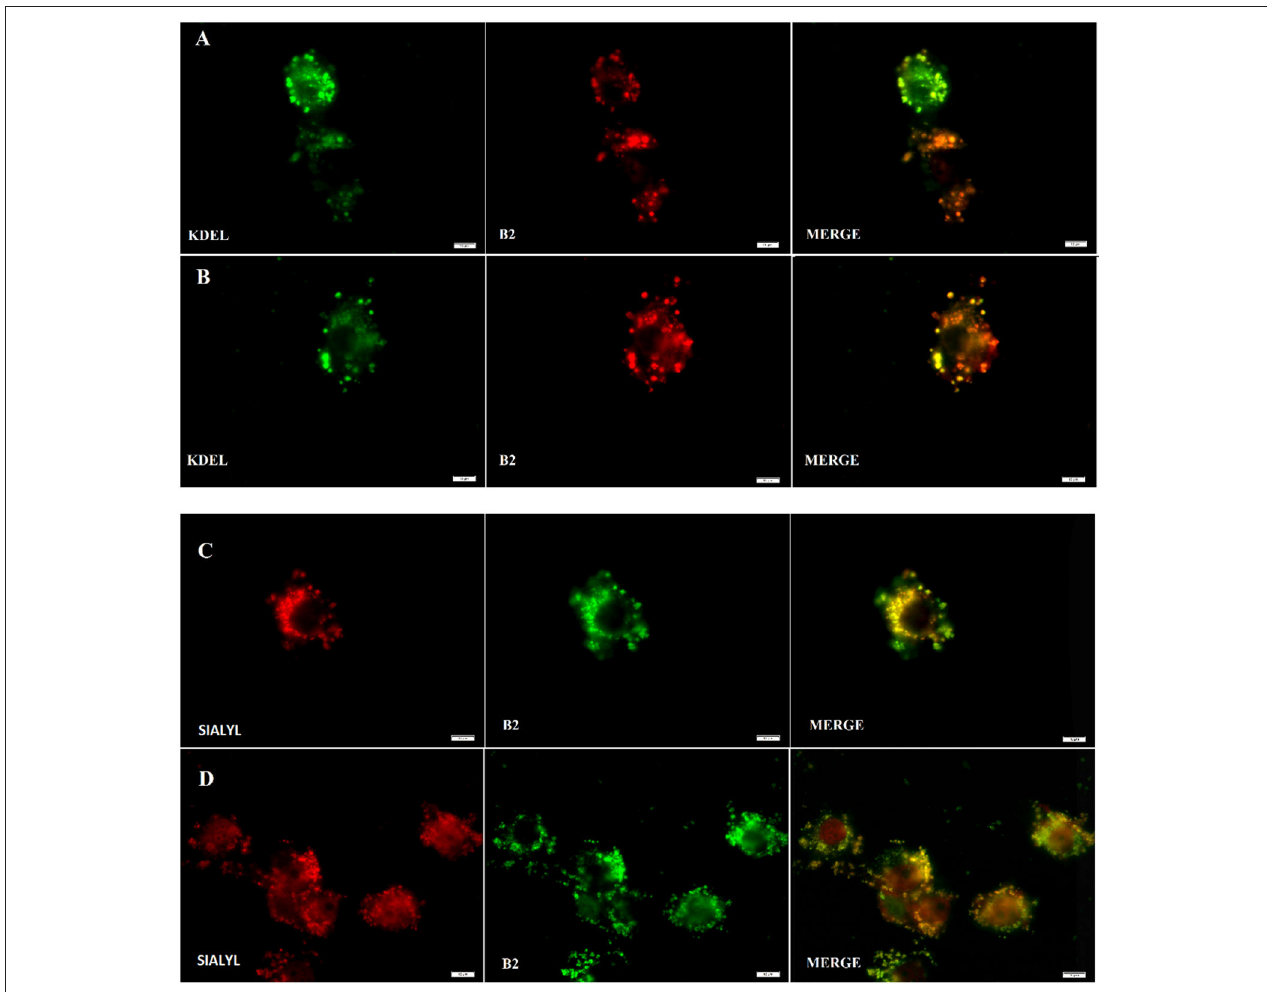
FIGURE 5 | B2 staining co-localizes with Endoplasmic Reticulum (ER) (A,B) and Golgi apparatus (C) , (D) . Fluorescence assay was performed using HeLa cells and analyzed under fluorescent microscopy at 48h post-transfection either with KDEL-GFP gene (A,B) or with Sialyl-RFP (C,D) . To stain with B2 , respective transfected cells were simply incubated with B2 at 50 µ g/mL for 30min at 37 ◦ C. In the case of B2 , a pseudo color was used to facilitate its visualization and co localization. White bars represent 10 µ m.